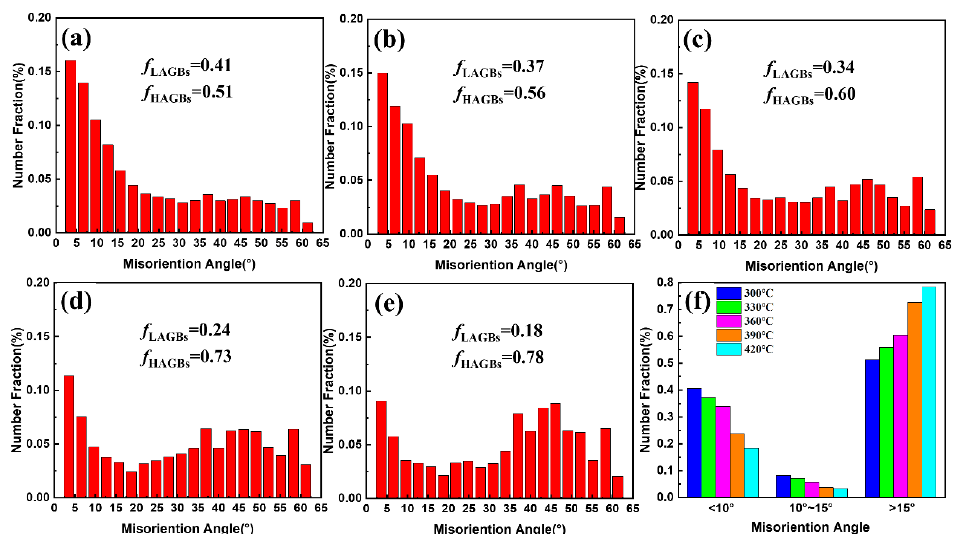
Figure 13. Distribution of grain boundary misorientation angles at different deformation temperatures with a strain rate of 0.1 s − 1 : ( a ) 300 ◦ C; ( b ) 330 ◦ C; ( c ) 360 ◦ C; ( d ) 390 ◦ C; ( e ) 420 ◦ C; ( f ) Comparison of misorientation angles.